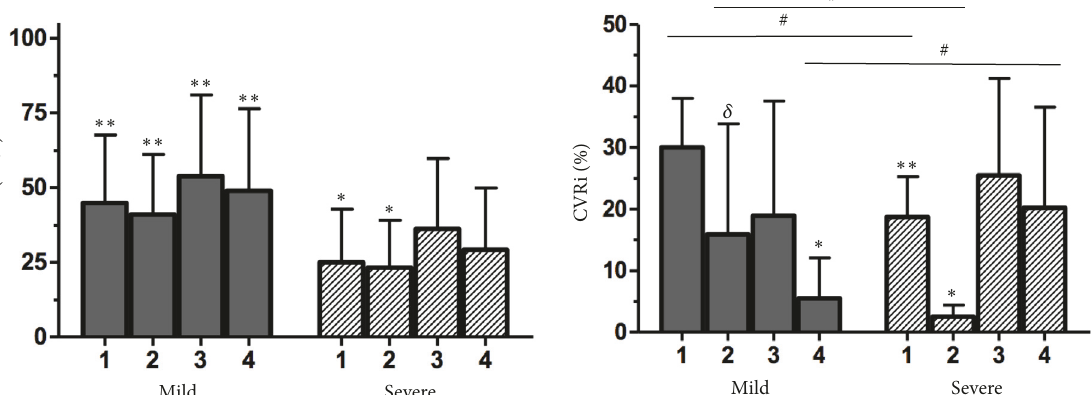
Figure 4: CBFV and CVRi in the mild and severe ICH groups during the experiment; CBFV ( ∗∗ p < 0.002 for the comparison with ICH and ∗ p=0.04 for the comparison with saline solution) and CVRi (#p < 0.02 for differences between the groups, ∗ p < 0.02 for differences between the assessments in the same group, ∗∗ p=0.001 for differences between assessments 1 and 3, and §p=0.04 for differences between assessments 1 and 2). CBFV (cerebral blood flow velocity), CVRi (Cerebrovascular resistance index), and ICH (intracranial hypertension); 1 (basal), 2 (balloon inflation), 3 (saline solution infusion), and 4 (balloon